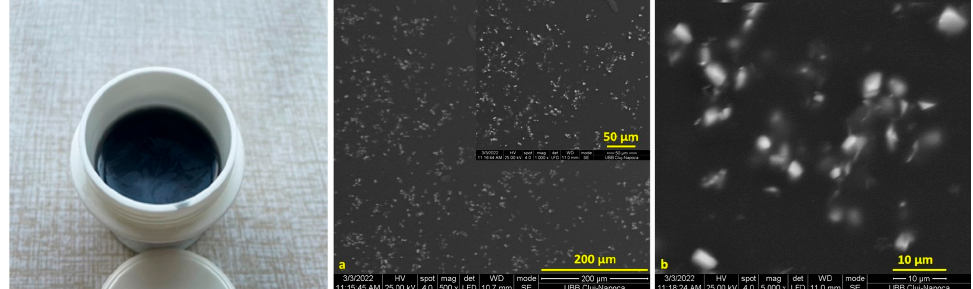
Figure 2. Images of the CuSO4-PEG 600 mixture (in plastic minicontainer) and ( a , b ) SEM images of Cu-PEG 600.